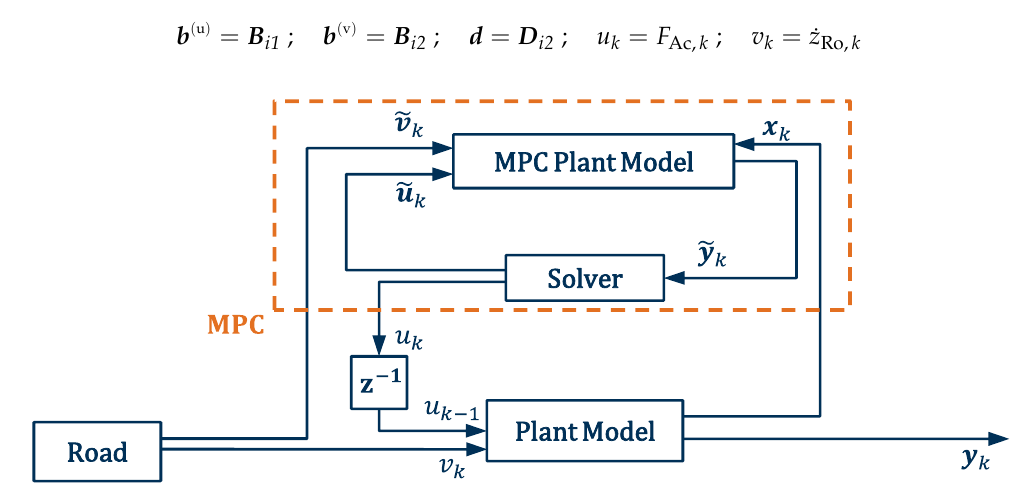
Figure 3. Schematic overview of the simulation